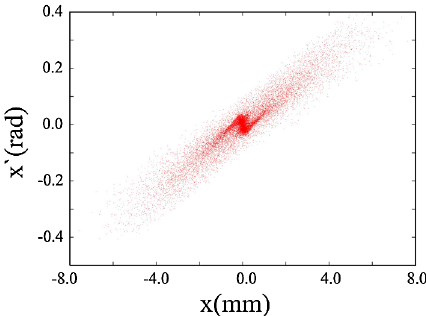
FIG. 13. The x - x 0 phase space projection of the whole trans- ported proton spectrum with 10 MeV (cid:2) 5 MeV at 460 ps. The pronounced core structure is dominated by the lower energy protons (compare with Figs. 12 and 15).